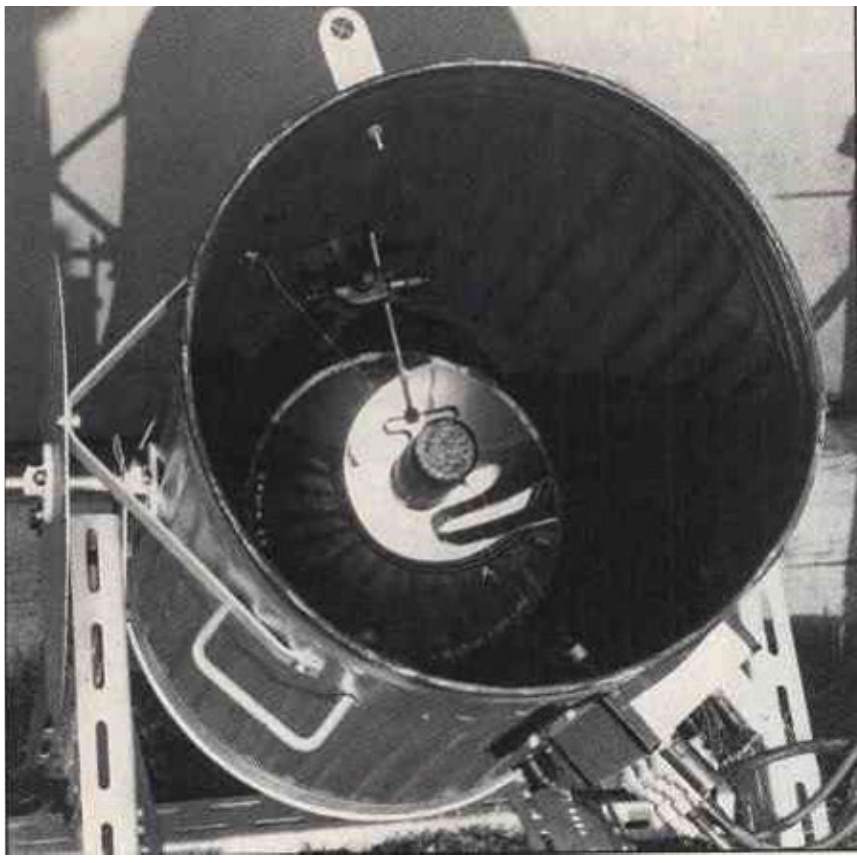
Figure 1. The original detector of W. Galbraith and J. V. Jelley described in [10].